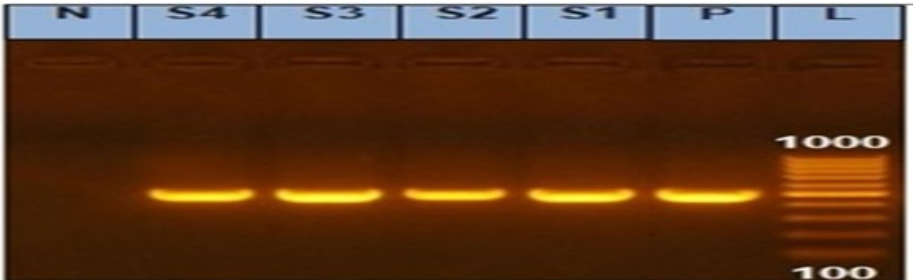
Figure 2. Agarose gel showing amplified products of integrase gene (491 bp) in Salmonella isolates. N: Control Negative; P: Control Positive; L: DNA ladder 100 bp; and Lanes (S1, S2, S3, and S4) examined Salmonella isolates (S1: S. Kentucky from calf and S2: S. Kentucky from chicken) and (S3: S. Entertidis from chicken and S4: S. Enteritidis from the calf).